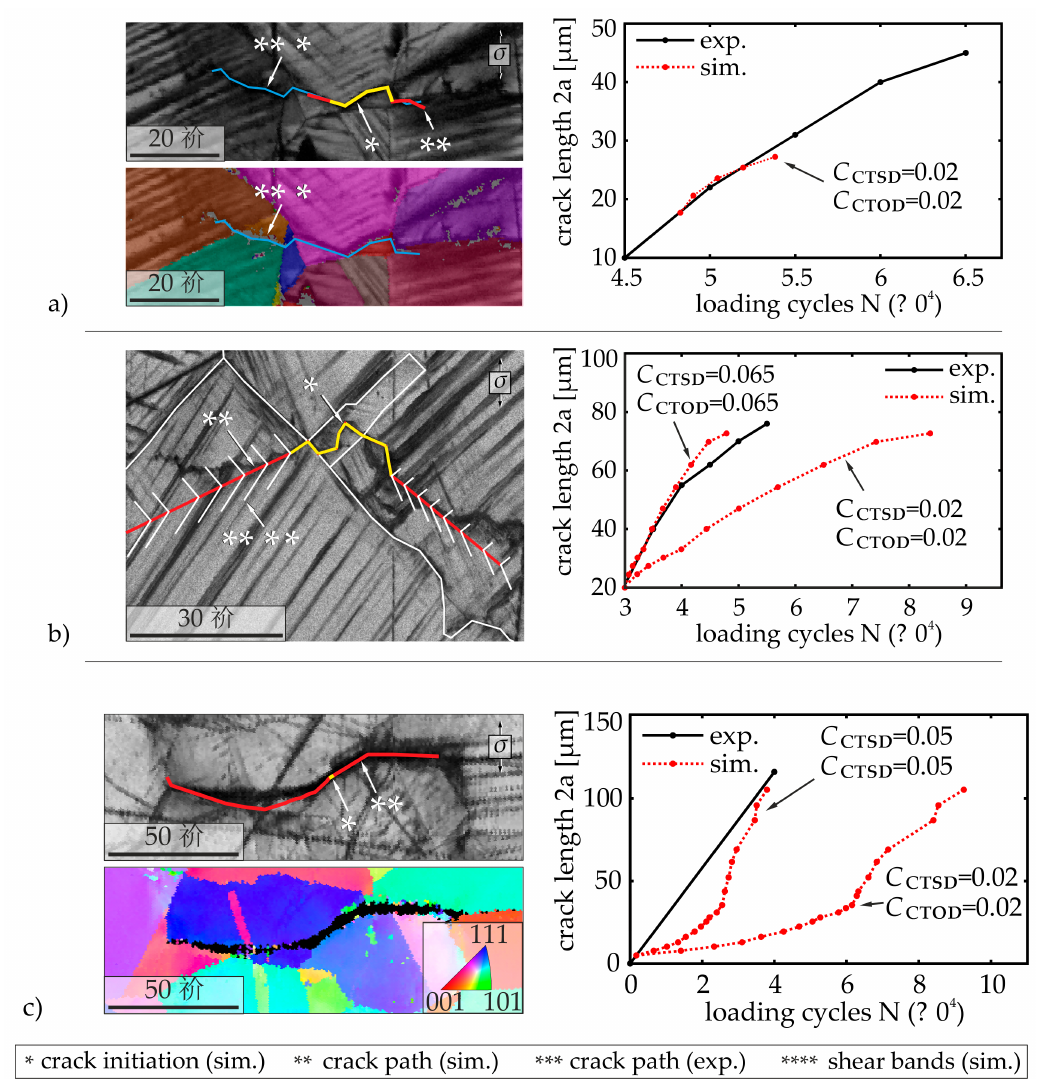
Figure 14. Scanning electron microscopy (SEM)- and EBSD-images of the crack path and comparison of the predicted crack growth with experimentally obtained results on specimens of X2–12 ( a ) in an uncharged specimen ( R = − 1, ∆ σ /2 = 365 MPa), ( b ) in a precharged specimen ( R = − 1, ∆ σ /2 = 365 MPa, c H = 40 wppm) and ( c ) in an uncharged specimen tested in 10 MPa hydrogen atmosphere ( R = − 1, ∆ σ /2 = 270